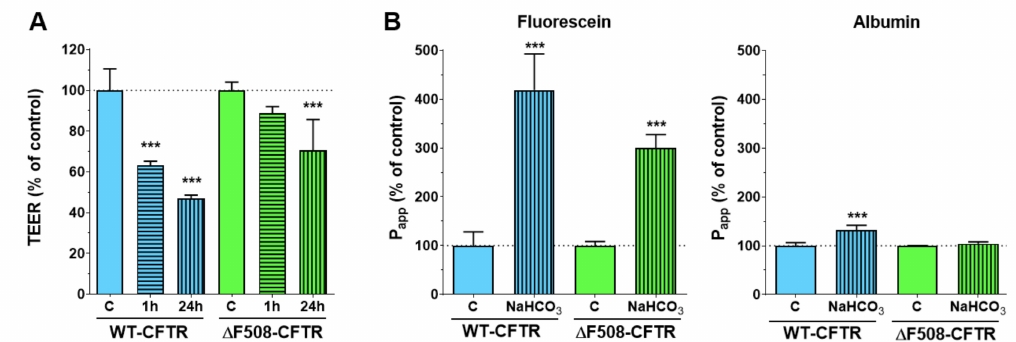
Figure 10. The e ff ect of sodium bicarbonate on the barrier integrity of CFBE cells in co-culture. Transepithelial electrical resistance (TEER) values at 1 and 24 hour time points ( A ) and permeability values ( B ) of the co-culture models after treatment with culture medium containing 26 mM (control group) or 100 mM sodium bicarbonate. Values are presented as a percentage of the control groups. Means ± SD, n = 4 / group. Statistical analysis: 2-way ANOVA and Bonferroni test. *** p < 0.001 compared to the control